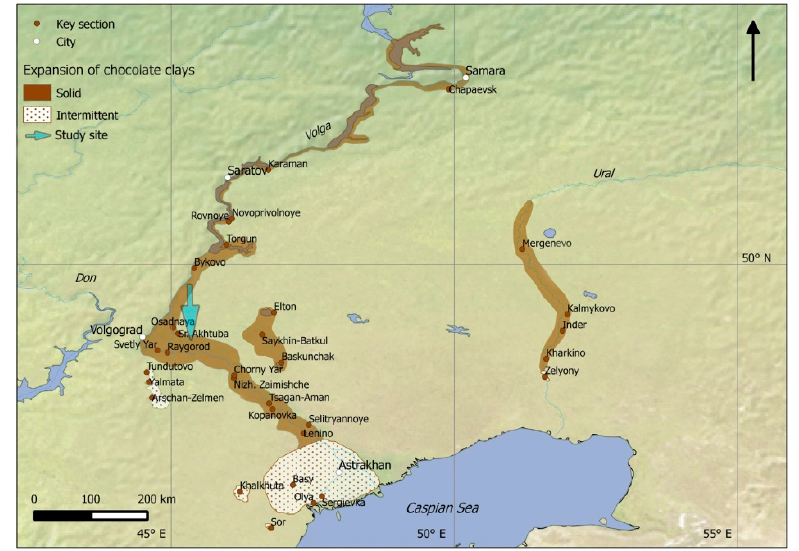
Figure 1. Study site area and spatial distribution of Chocolate clays in the Northern Caspian and Volga regions ( [7] , modified). The arrow points to the Srednaya Akhtuba study site.